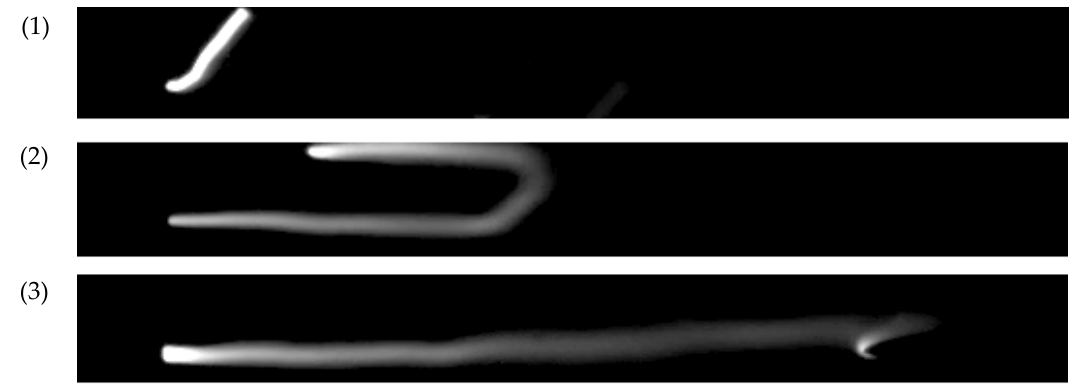
Figure 4. Photos of the discharge channel in the supersonic flow: (1,2) launch and (3) stable operation.